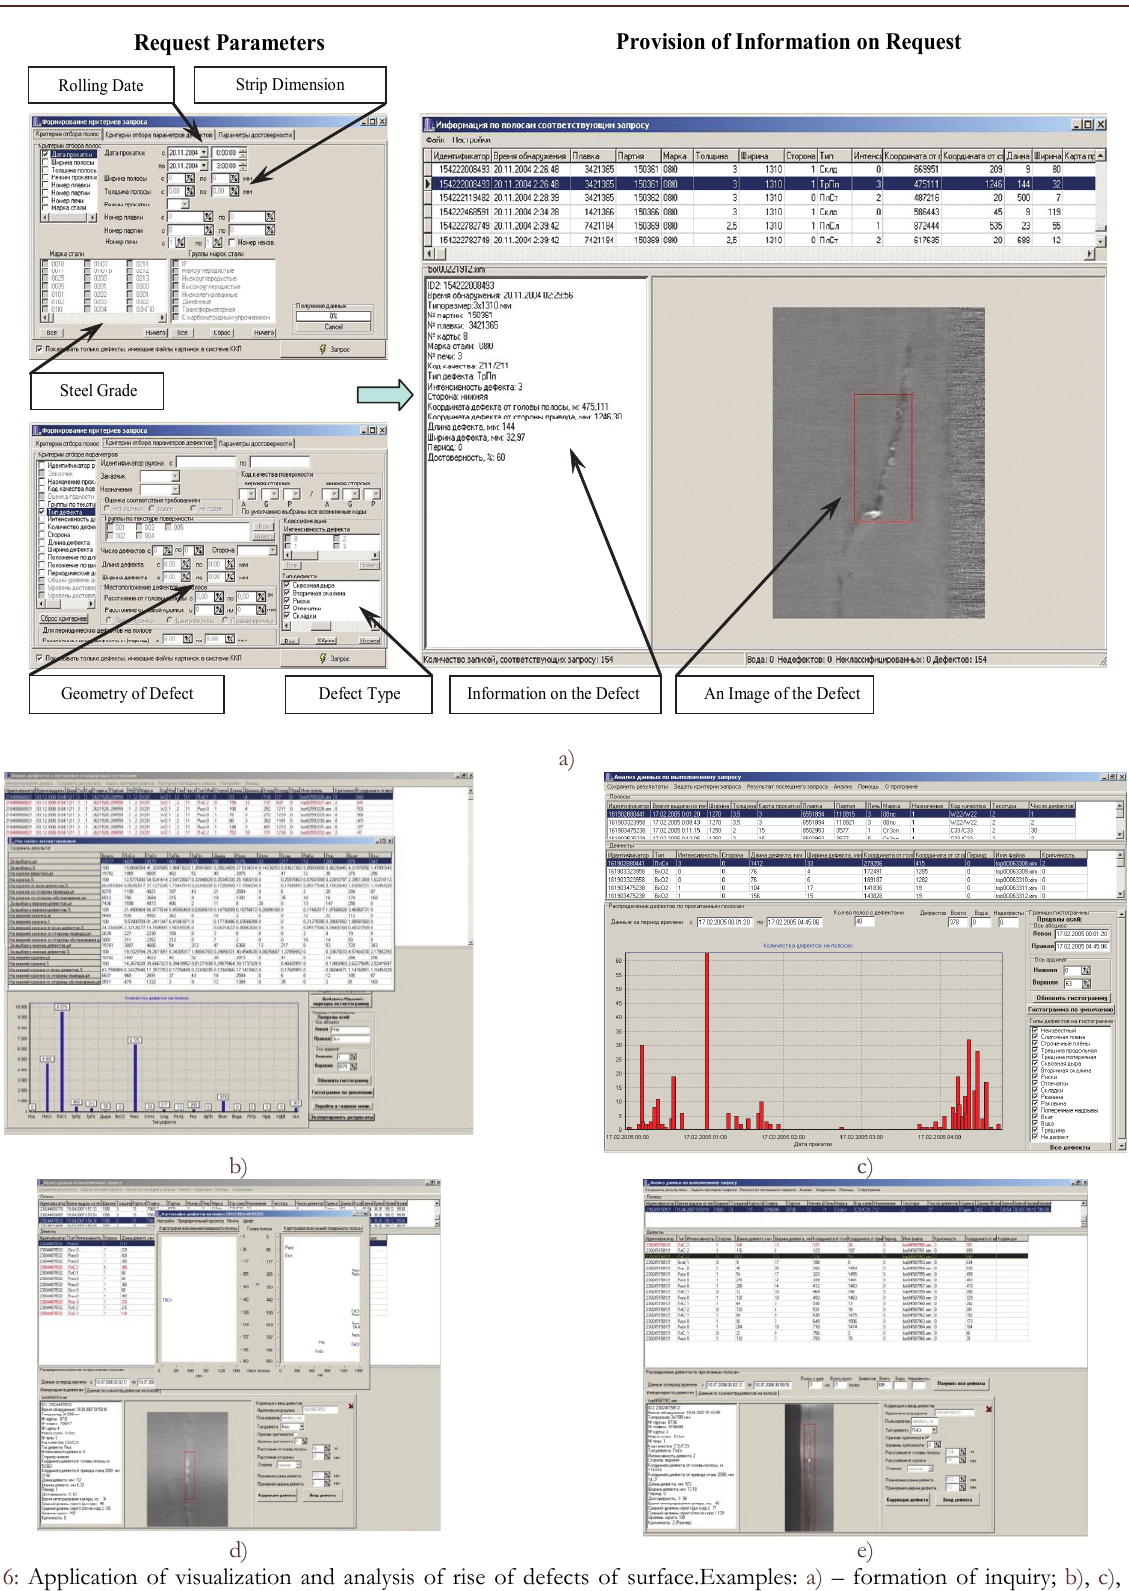
Figure 6: Application of visualization and analysis of rise of defects of surface.Examples: а ) – formation of inquiry; b), c), d), e) – results of processing of